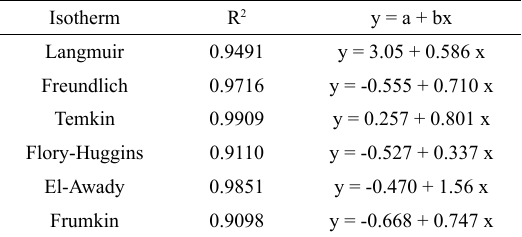
SO 1.5 mol L -1 . 2 4